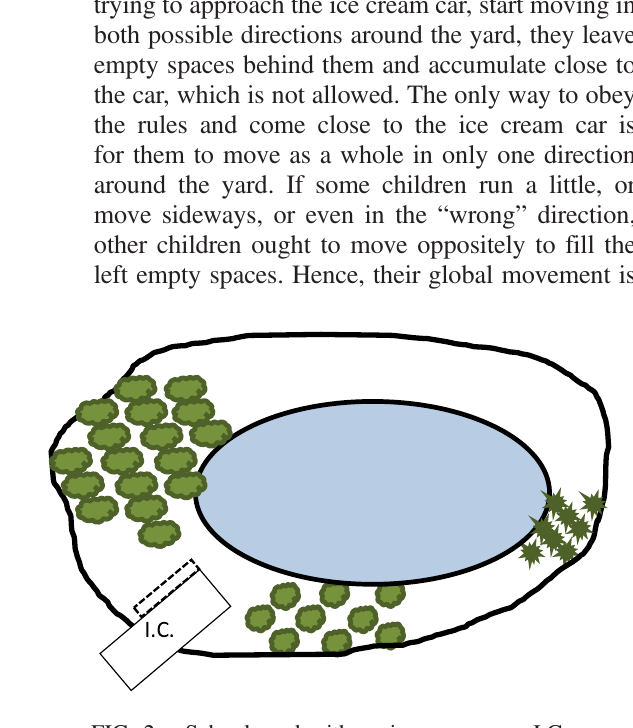
FIG. 2. School yard with an ice cream car,